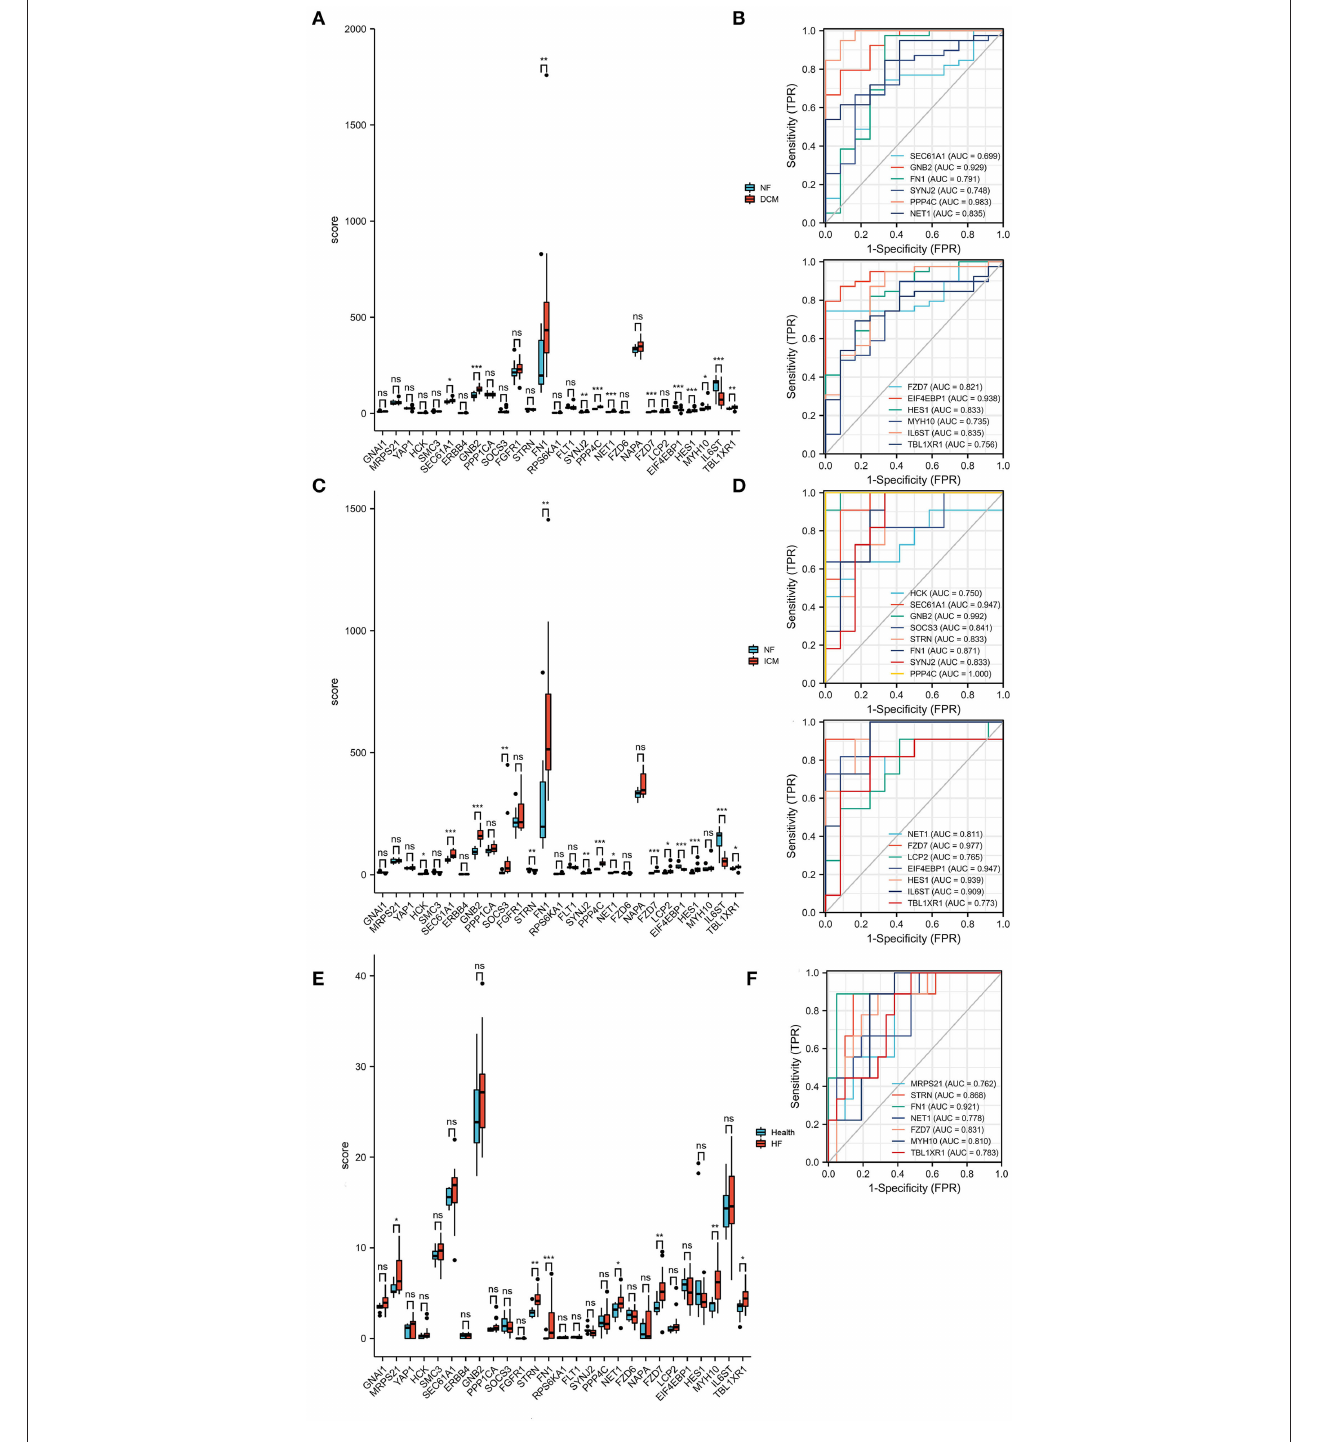
FIGURE 6 | Expression patterns of the hub differentially expressed macrophages-related genes (DEMRGs) were validated in the GSE116250 and GSE135055 datasets. (A) The expression level of the hub DEMRGs in patients with dilated cardiomyopathy compared to control. (B) The receiver operation characteristic (ROC) curves of the validated DEMRGs in patients with dilated cardiomyopathy. (C) The expression level of the hub DEMRGs in patients with ischemic cardiomyopathy compared to control. (D) The ROC curves of the validated DEMRGs in patients with ischemic cardiomyopathy. (E) The expression level of the hub DEMRGs in patients with ischemia-induced heart failure compared to control. (F) The ROC curves of the validated DEMRGs in patients ischemia-induced heart failure. DCM, dilated cardiomyopathy; ICM, ischemic cardiomyopathy; HF, heart failure. * p < 0.05; ** p < 0.01; *** p < 0.001; ns, not significant.